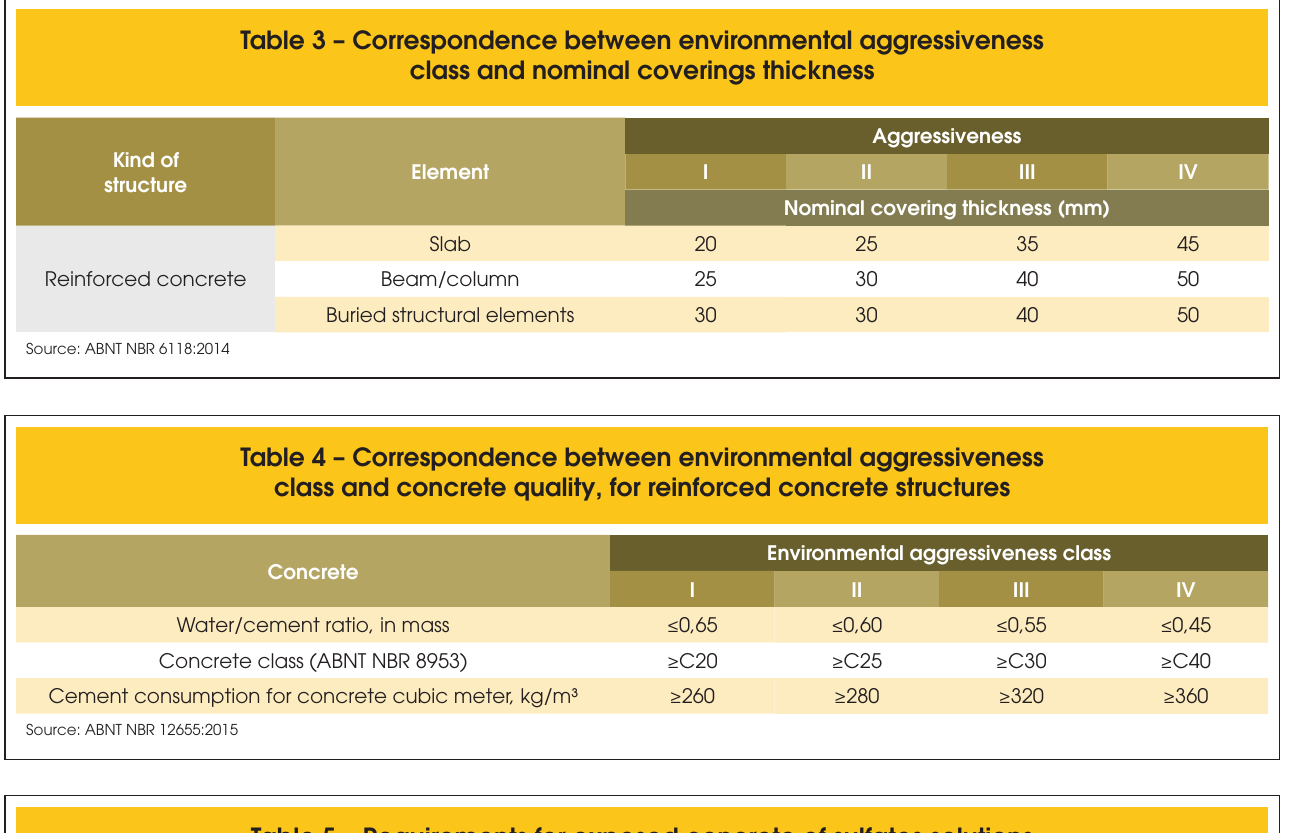
Table 5 – Requirements for exposed concrete of sulfates